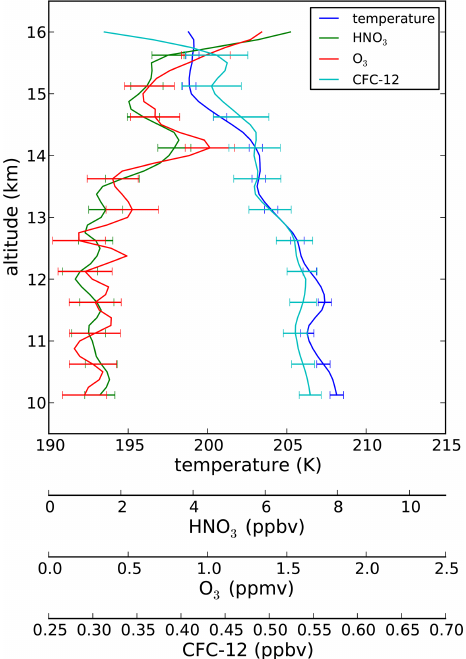
Figure 7. Retrieved temperature, HNO 3 , O 3 , and CFC-12 for GLO- RIA Image 72.